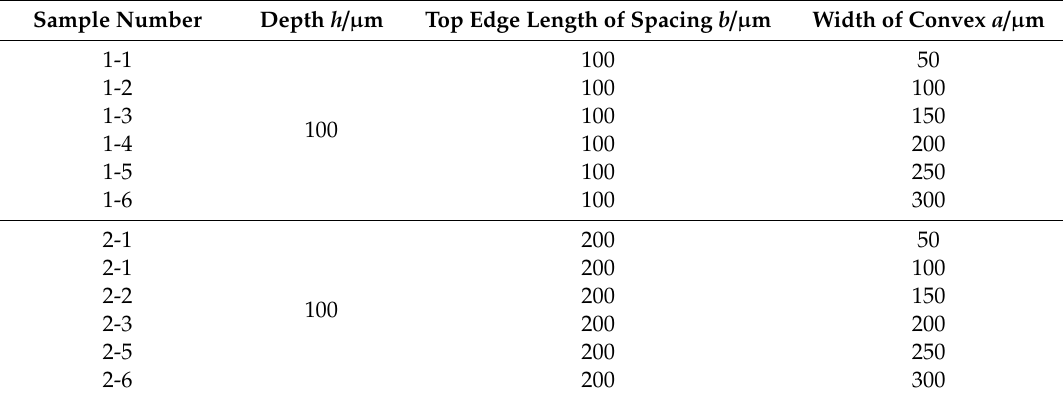
Table 1. Parameters of trapezoidal groove structure.